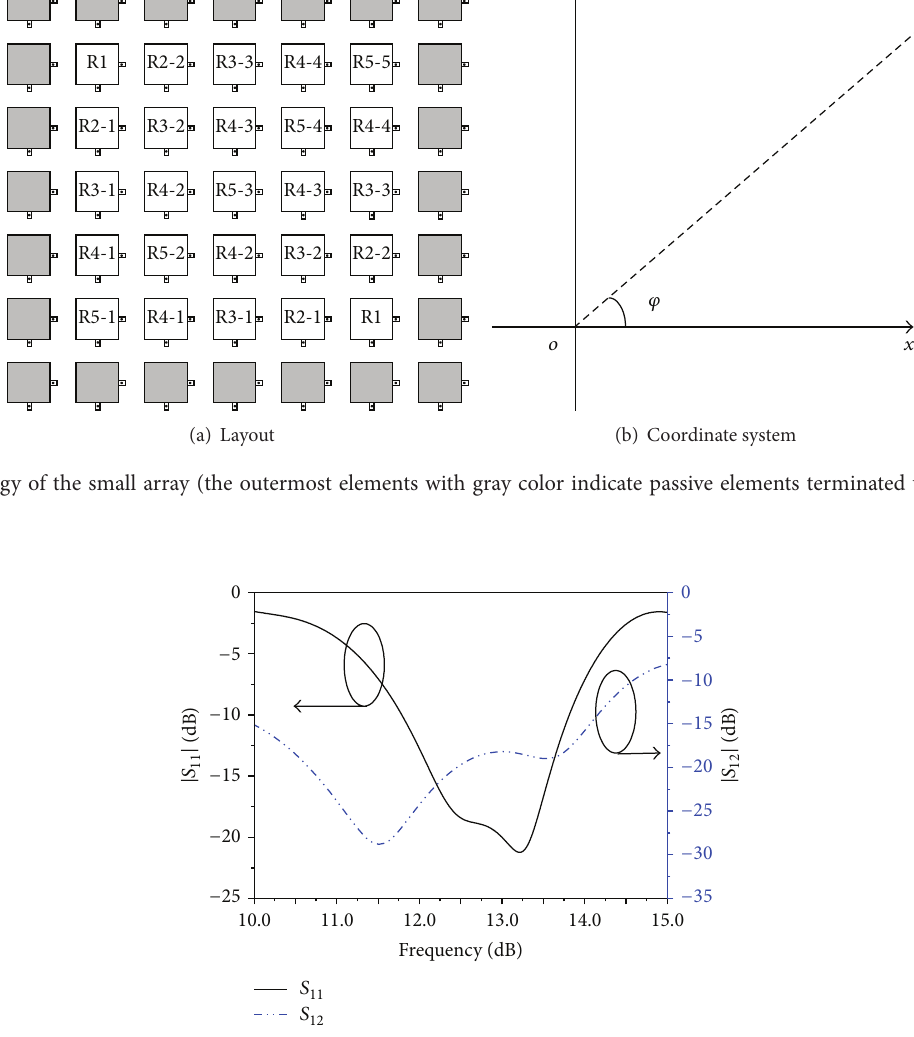
Figure 3: The simulated 𝑆 11 and 𝑆 12 of isolated antenna element.